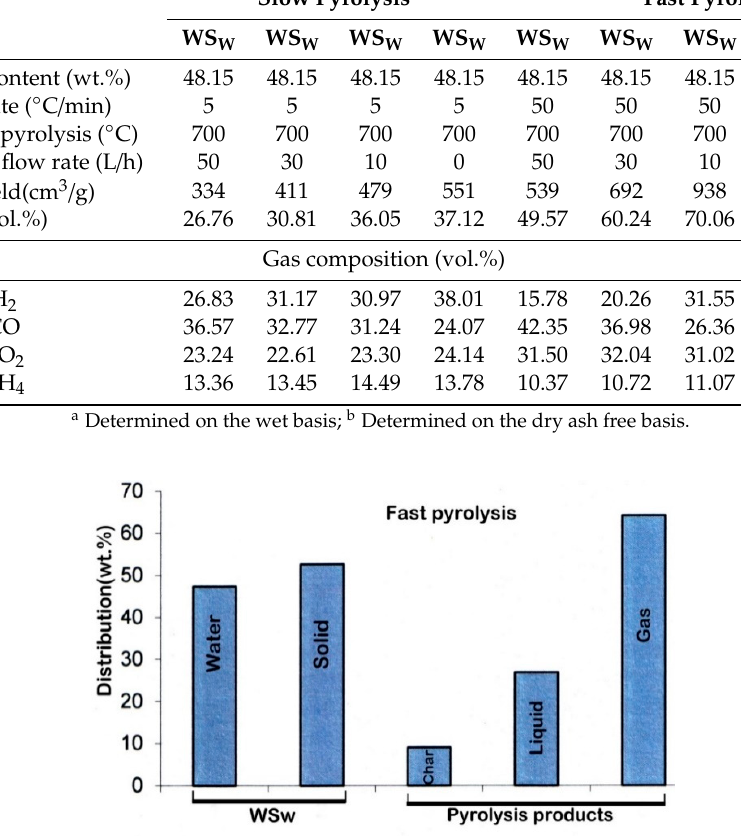
Figure 9. The distribution of water and solid fractions for WS W and its pyrolysis products. The test was performed under the fast pyrolysis process without N 2 stripping gas.